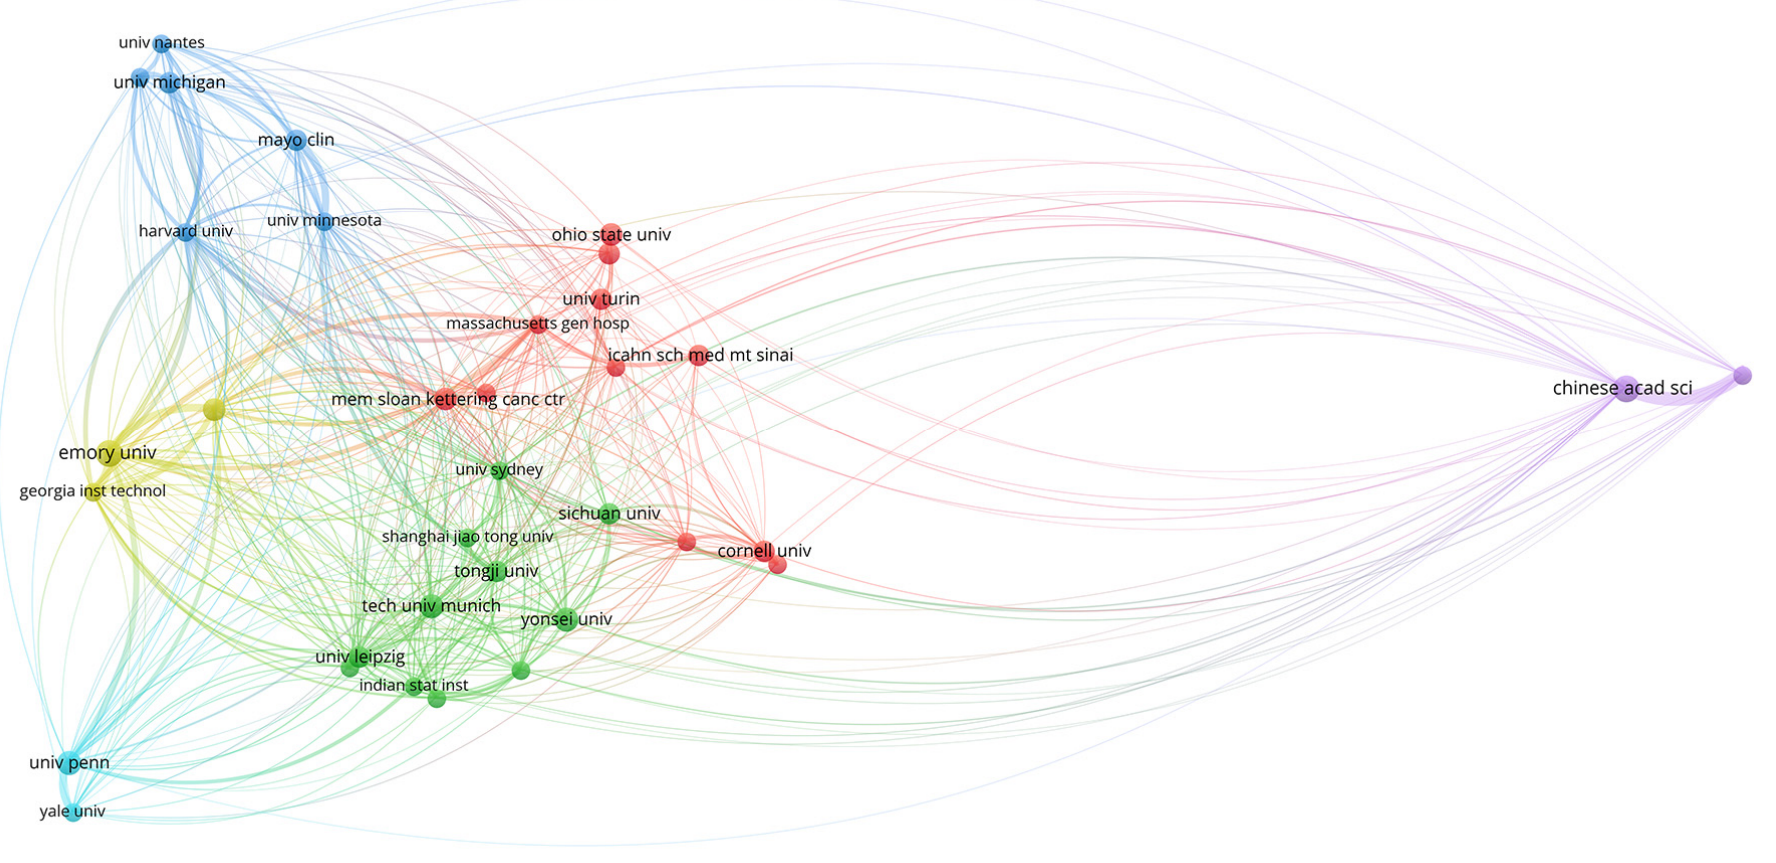
Figure 5. World map showing the structure of relations among research institutions as shown in the network visualization module of the VOSviewer software. The map shows the bibliometric coupling relation among institutions according to the number of documents published for each